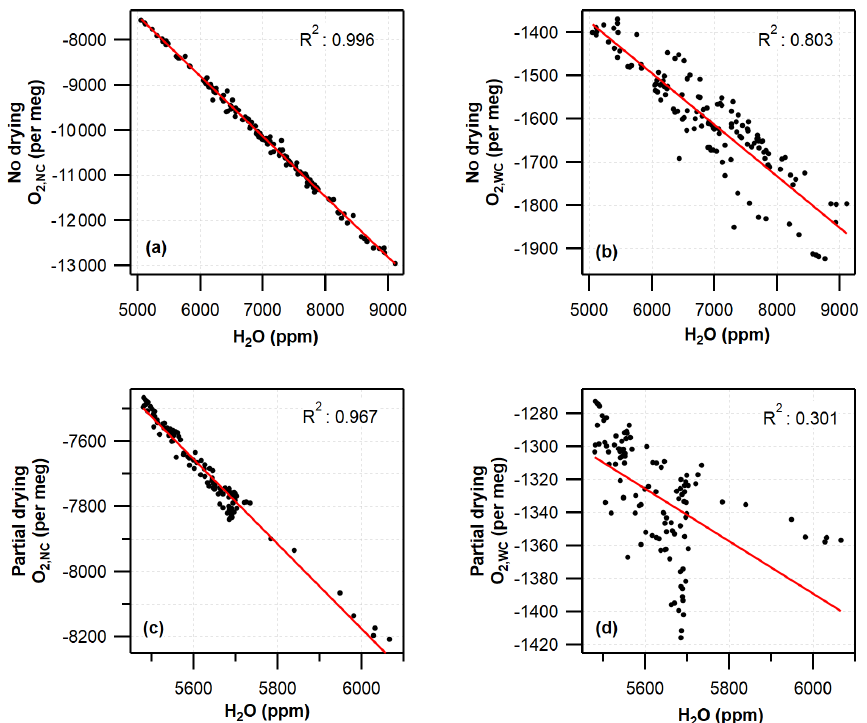
Figure 6. Correlation between water vapour mole fraction and hourly averaged G2207- i O 2 for (a) no-drying O 2 , NC , (b) no-drying O 2 , WC ,